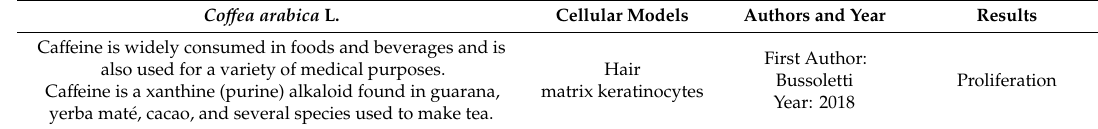
Table 4. Schematic representation of in vitro cellular models used to test the role of Co ff ea arabica L. Co ff ea arabica L.